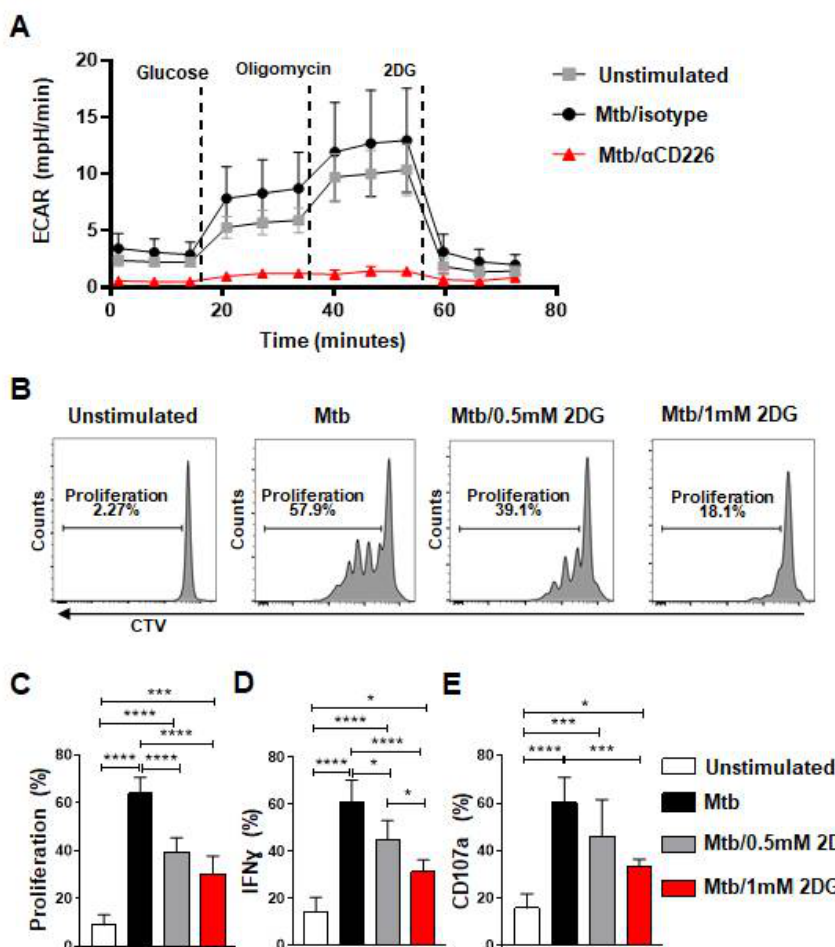
Figure 4. Blockade of CD226 reduced glycolysis in NK cells and glycolysis inhibition diminished effector function of mlNKs from LTBI+ donors after stimulation with Mtb. ( A ) PBMC from LTBI+ donors were stimulated with γ-Mtb for 48 h and treated with isotype or blocking CD226 antibody. After this, 5 × 10 5 purified NK cells (purity > 90%) were plated to perform the glycolysis assay using seahorse analyzer (n = 4). ( B ) Chemical blockade of glycolysis using 2DG (0.5 or 1 mM every three days) after stimulation with γ-Mtb for 5-day time period was complete. ( B – E ) Proliferation, frequencies of IFN- γ + cells and CD107a+ cells among CD3 − CD45+CD56+CD27+ cells unstimulated or stimulated with γ -Mtb and treated with 2DG (n = 5). Mean ± s.d. ANOVA. * p < 0.05, *** p < 0.001, **** p <